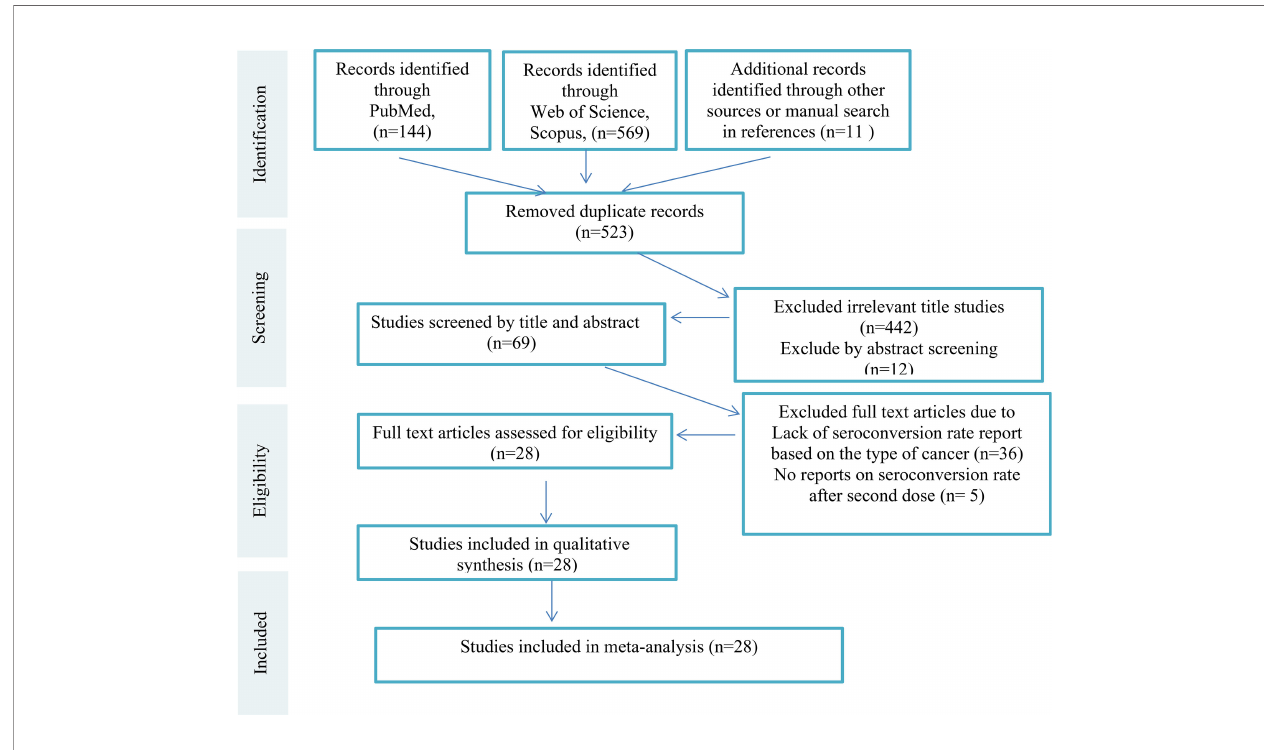
FIGURE 1 | PRISMA Flow